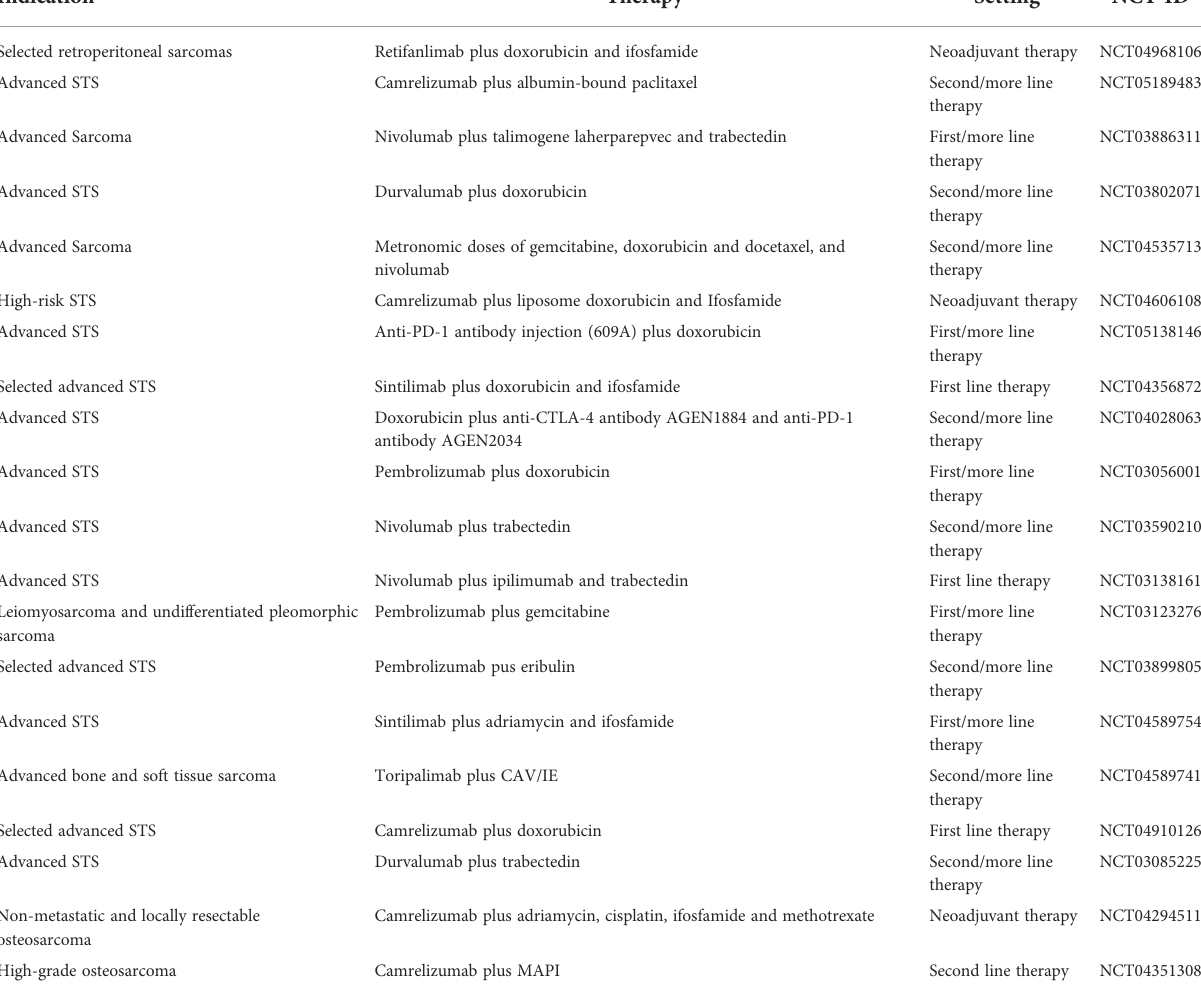
TABLE 3 Highlighted ongoing clinical trials of PD-1/L1 inhibitor plus chemotherapy for sarcomas. Indication Therapy Setting NCT